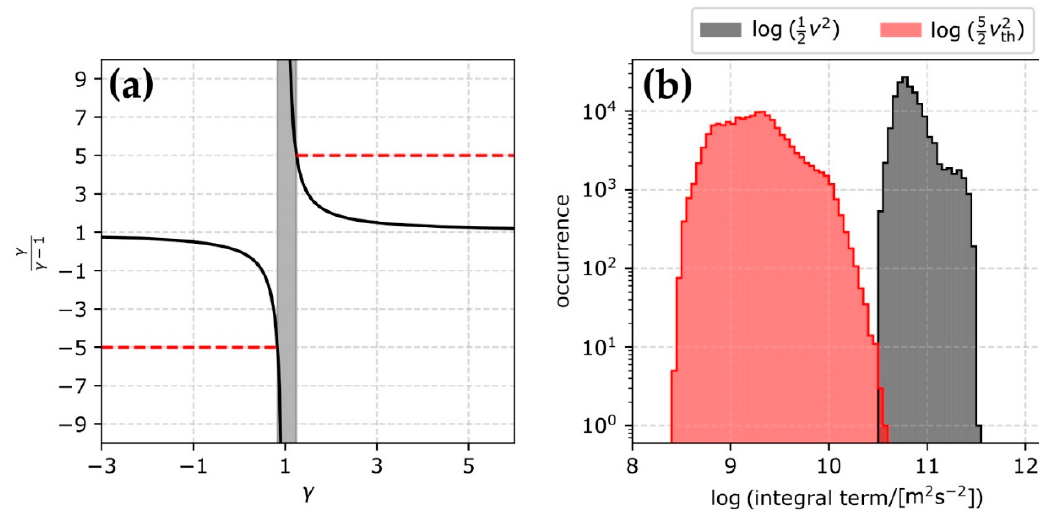
Figure 3. ( a ) The term γ as a function of γ . The grey ribbon indicates the range of γ for which the absolute value of γ γ − 1 exceeds 5 (red dashed). ( b ) the histograms of (grey) the dynamic term and (red) the absolute value of the thermal term of the Bernoulli integral assuming plasma with γ = 5 (or − 5). γ − 1